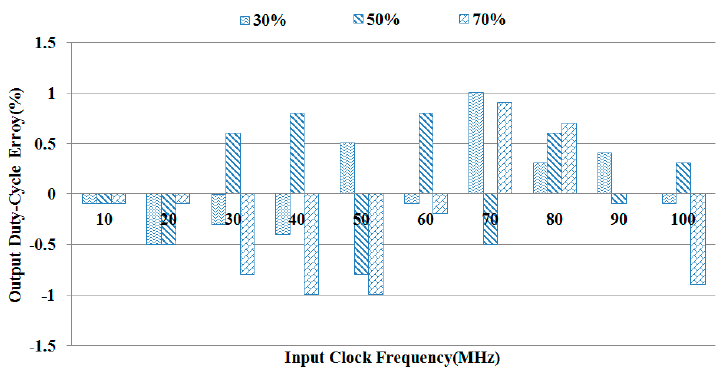
Figure 13. Output jitter histogram for a 100MHz signal.